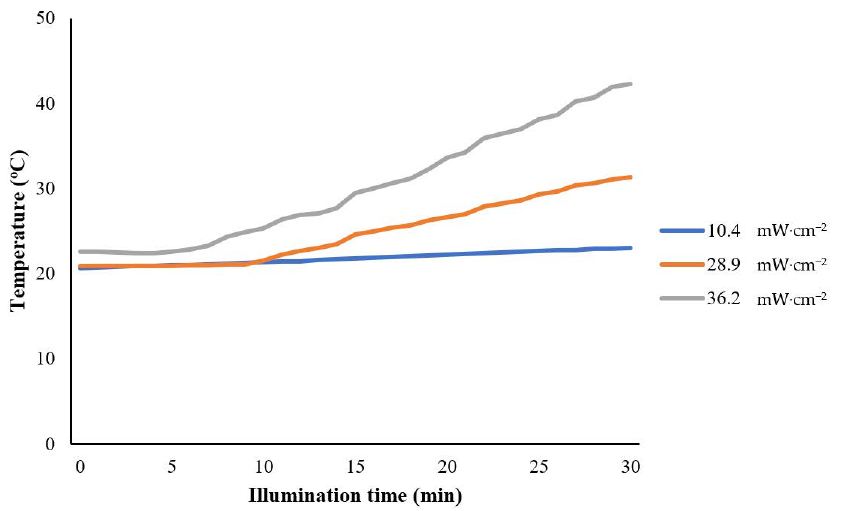
Figure 1. Temperature profile inside the light chamber upon blue LED illumination at three different irradiances (10.4, 28.9 and 36.2 mW · cm − 2